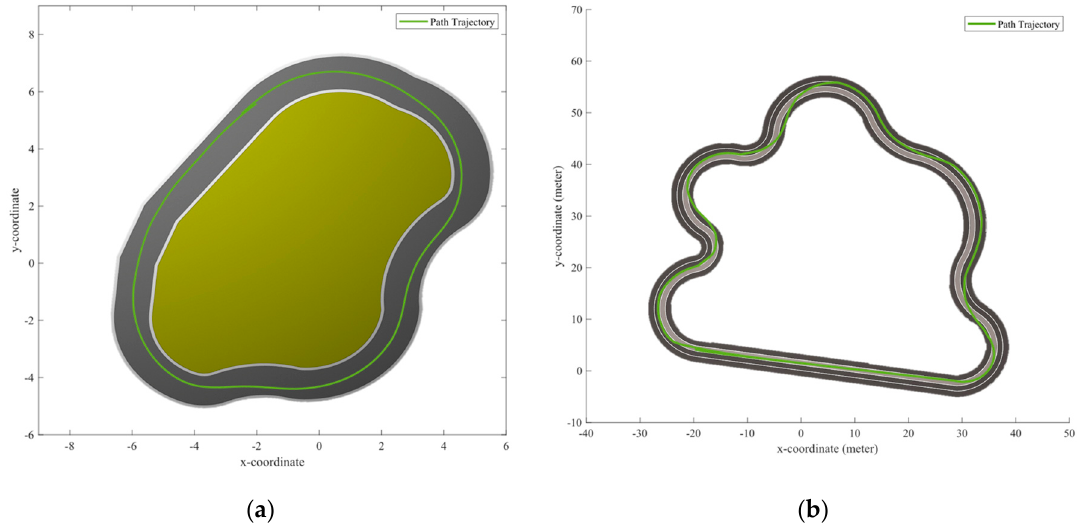
Figure 13. Plotted graph of the trajectory path of the ground vehicle; ( a ) Normal Track Environment, ( b ) Athletic field Track.